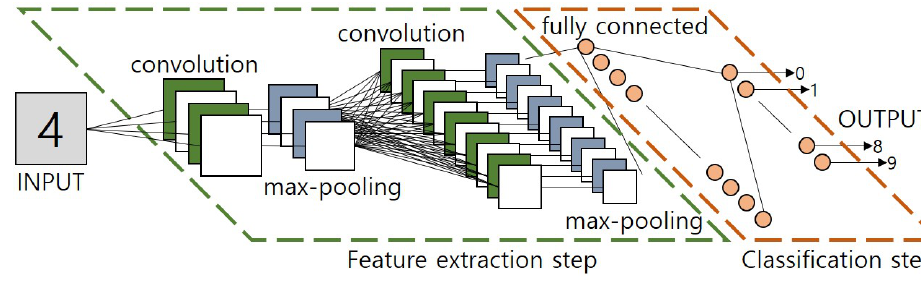
Figure 2. LeNet architecture.